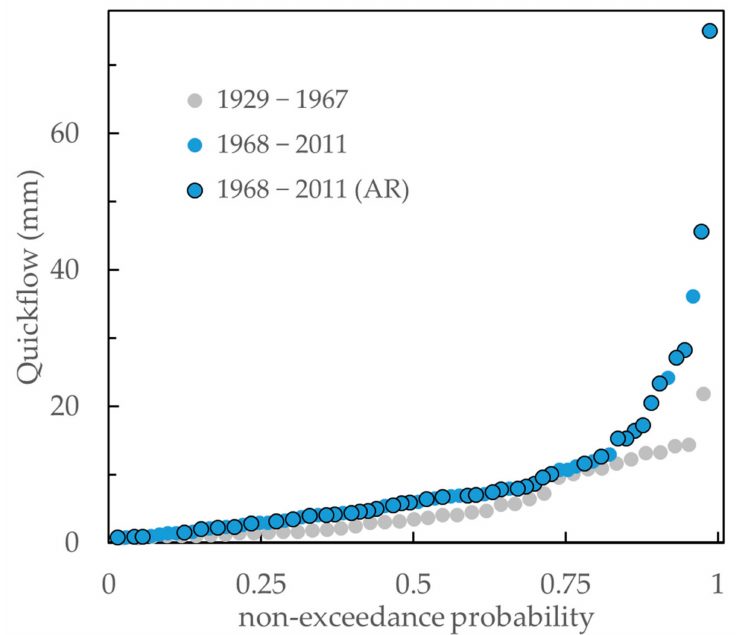
Figure 9. Frequency distributions of 60-day area-normalized magnitudes for quickflow response intervals (QRIs) in the Salt River basin during the winter seasons during an early period (1929–1967) and the study period (1968–2011). Magnitudes of winter QRIs were significantly larger in the study period compared to the early period (Mann-Whitney U-test). QRIs with black outline overlapped with known atmospheric rivers that were studied from 1979–2011